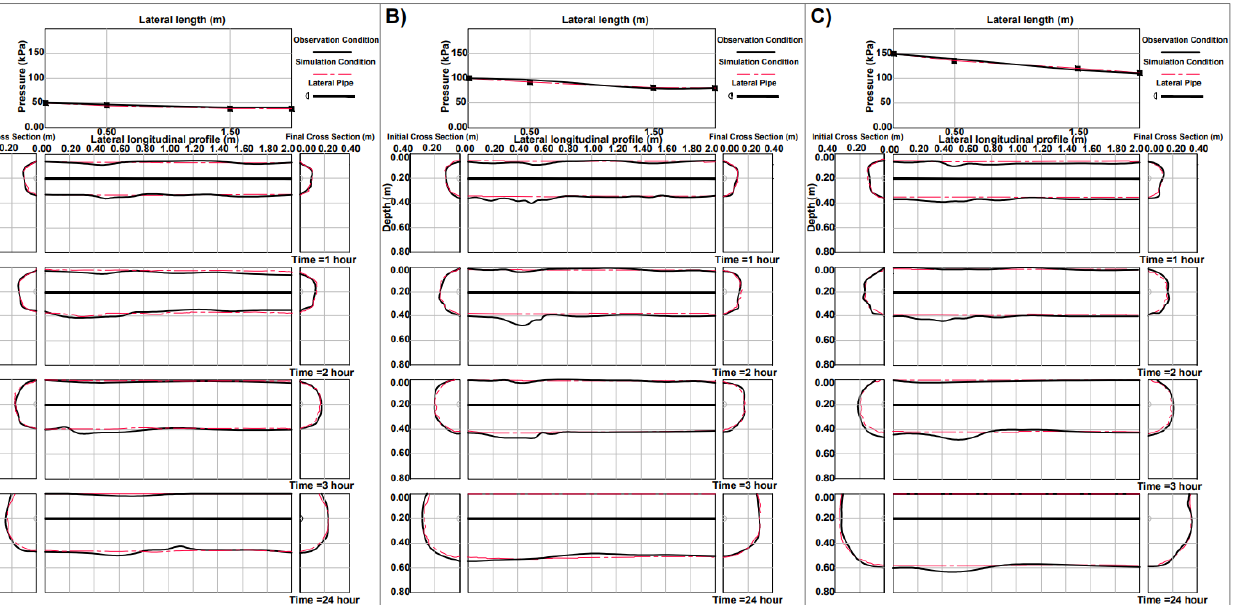
Figure 5. Comparison between observed and simulated wetting fronts for drip lateral with 20 cm minimum wetted areas were 0.497, 0.021, and 0.018 m 2 after 1 h beneath the drip lateral with 50 cm emitter spacing at the operating pressure of 50 kPa.